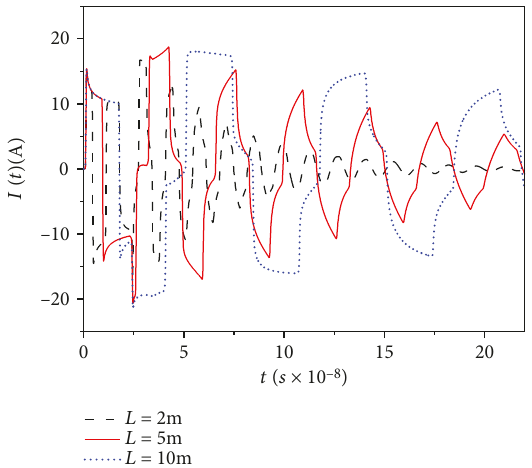
Figure 11: The variation of the re fl ection coe ffi cient of incident